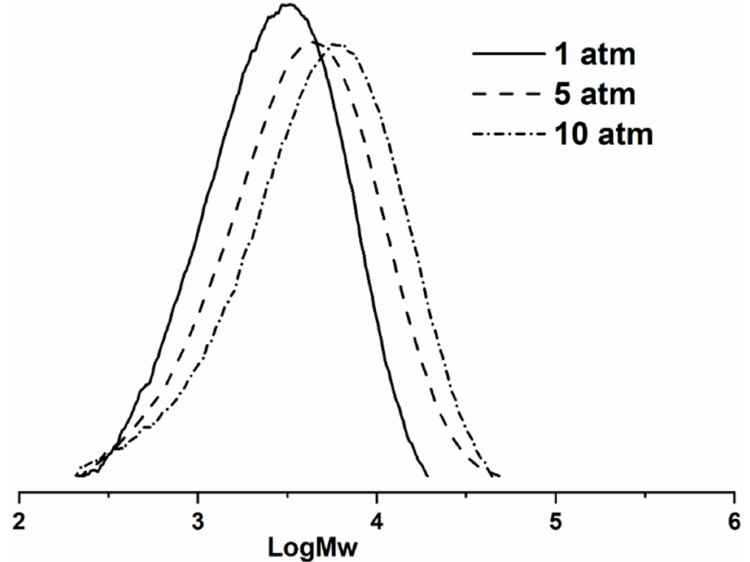
Figure 8. GPC curves showing log M w of the polyethylenes produced using Co1/ MMAO as a function of the ethylene pressure (entries 10, 17, and 18, Table